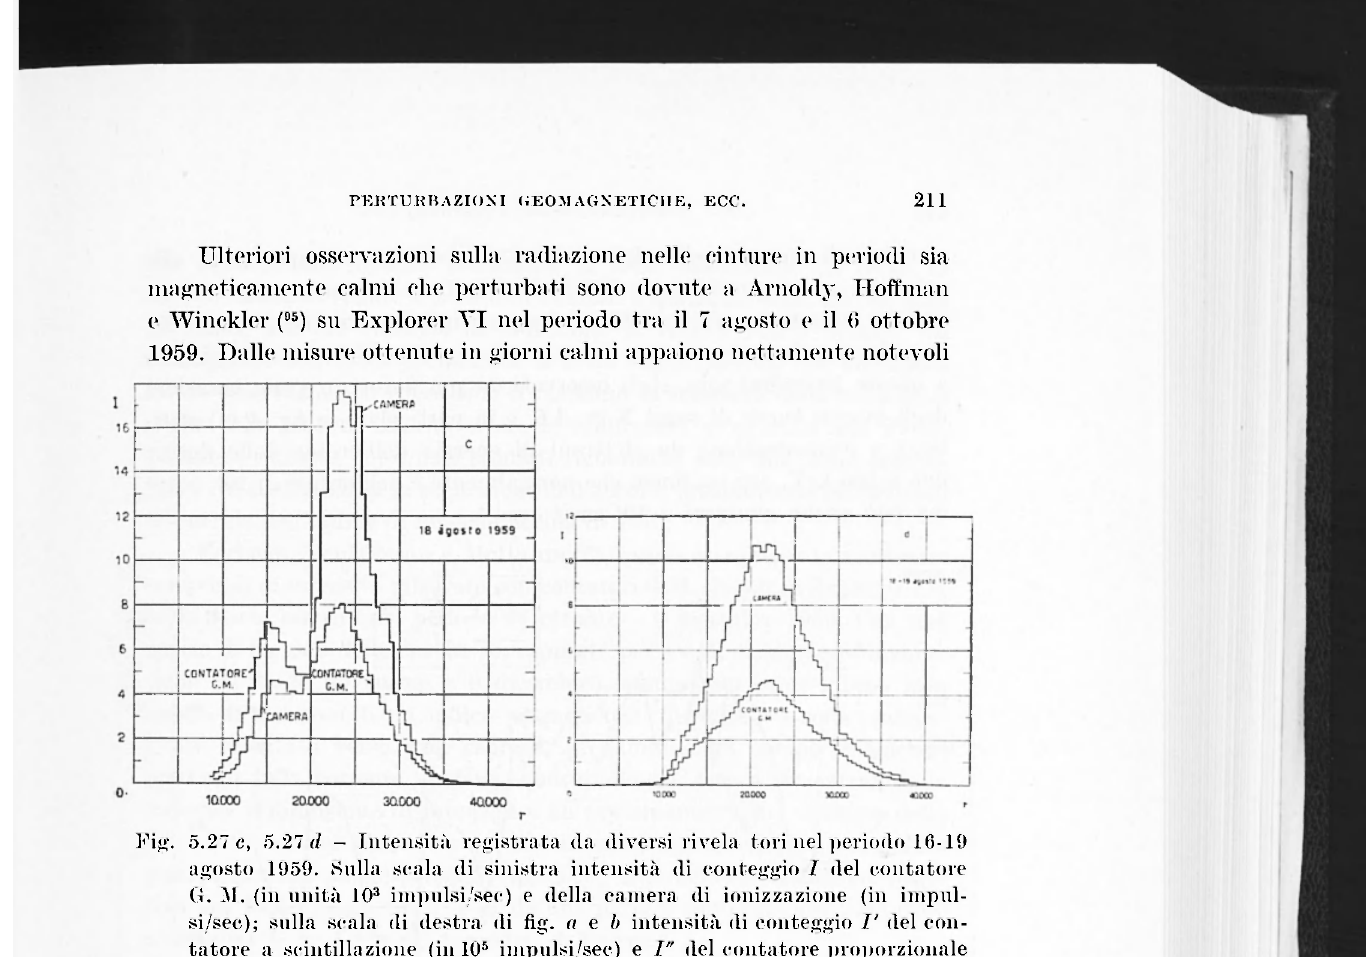
Fig. 5.27 c, 5.27 d - Intensità registrata da diversi rivela tori nel periodo 16-19 agosto 1959. Sulla scala di sinistra intensità di conteggio I del contatore CI. 31. (in unità IO 3 impulsi/sec) e della camera di ionizzazione (in impul- si/sec); sulla scala di destra di fig. a e b intensità di conteggio I' del con- tatore a scintillazione (in IO 5 impulsi/sec) e I" del contatore proporzionale (in IO 2 impulsi/sec); r, distanza geocentrica in km; i risultati delle fig. c e d sono stati ottenuti rispettivamente a molto basse e ad alte latitudini geomagnetiche (secondo Arnoldy, Hoffman e